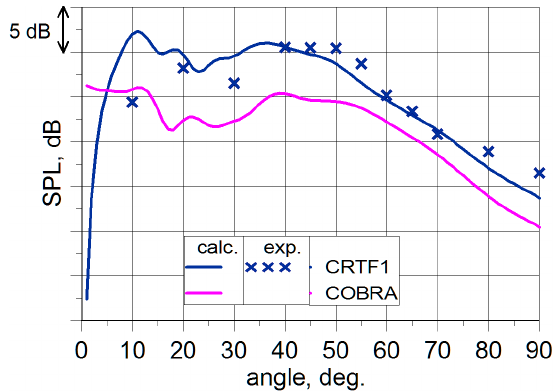
Figure 42. Summarized directivity diagrams of sound pressure level for CRTF1 fan (computation and experiment) and for COBRA1 fan (computation).